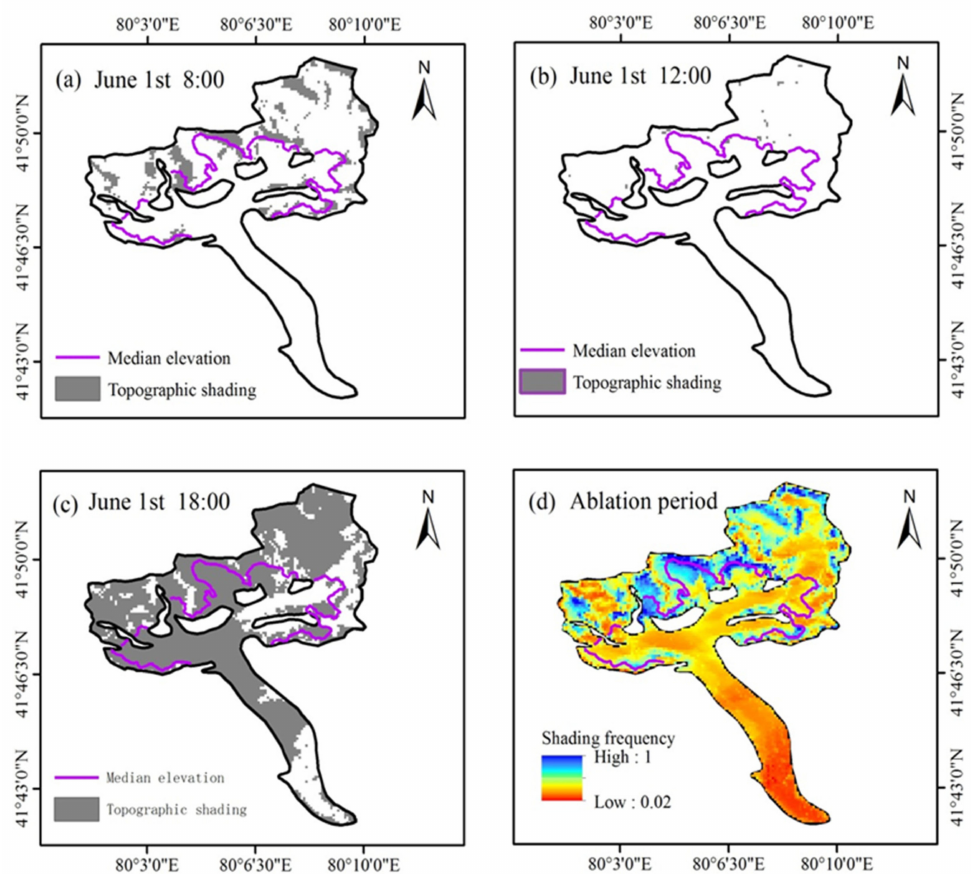
Figure 3. Topographic shading of Koxkar glacier at different